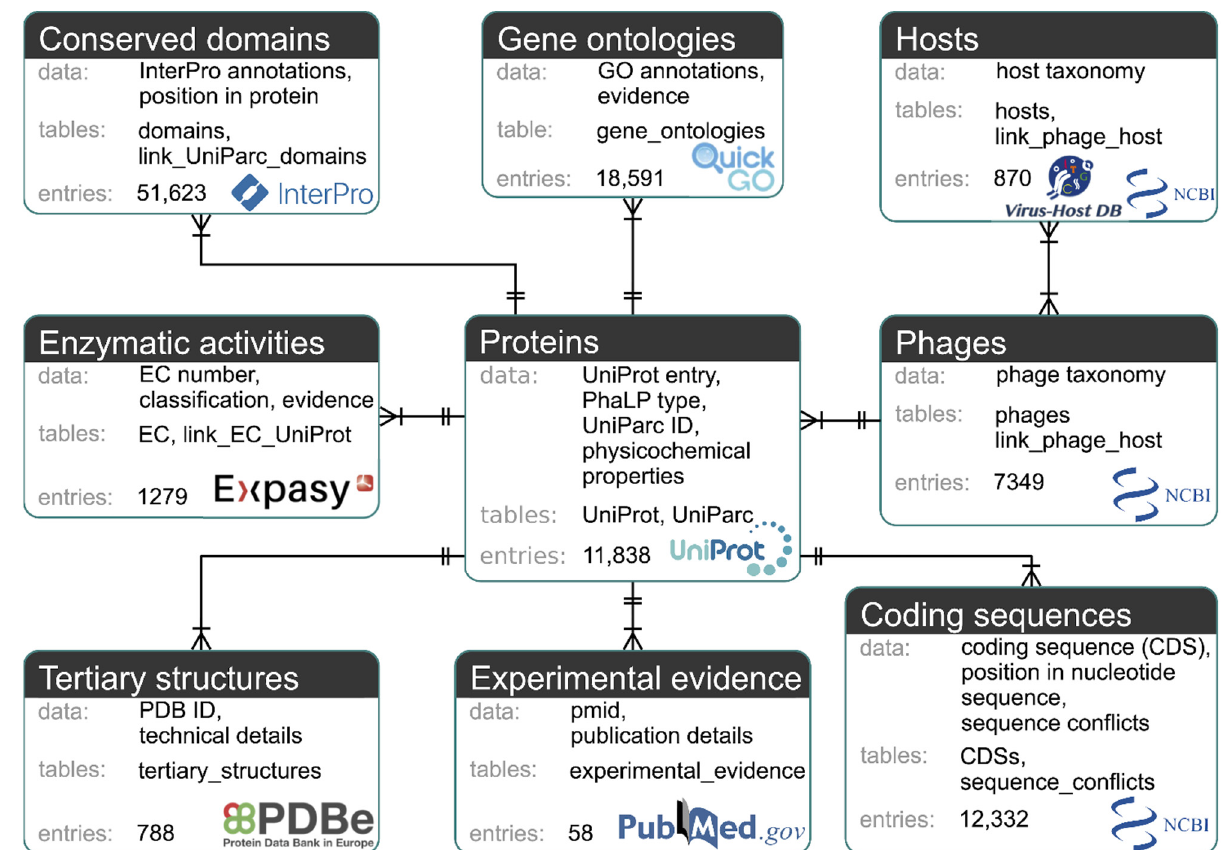
Figure 2. Diagram of the nine data types of PhaLP. Each data type is represented by a box containing a description of the data, the corresponding MySQL table(s), the number of entries in PhaLP v2019_10 and the source database. Relationships between data types are indicated with a crow’s foot notation. A relationship is indicated by a line between two data types with a double perpendicular line at a “one” side and a crow’s foot at a “many” side. The “one-to-many” relationship between for example “phages” and “proteins” can be interpreted as: one phage entry can be linked to multiple protein entries, but each protein entry can only be associated with one phage entry. The “many-to-many” relationship between “hosts” and “phages” can be interpreted as: a phage can have multiple hosts, but a host can also be associated with multiple phages.